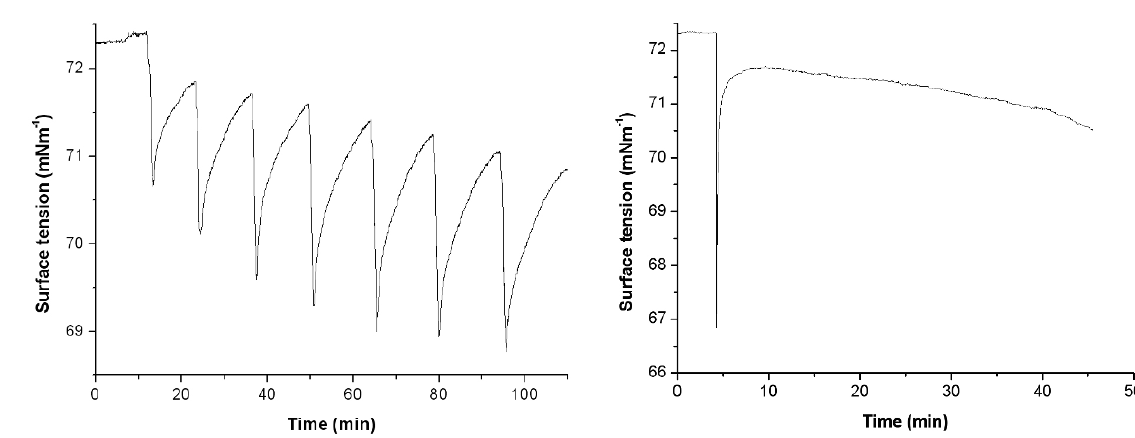
Figure 4. Single oscillation of the surface tension followed by the quasi-stationary regime. Dissolution of an octanol droplet in the vessel with diameter d=48 mm, the capillary immersion depth h=5.3 mm (reprinted from [33], with permission from American Chemical